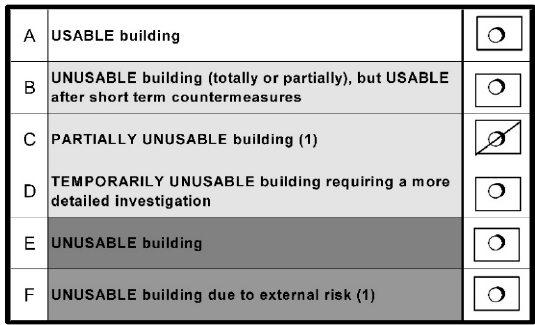
Figure 3. Usability judgments according to the AeDES form—adapted from Baggio et al.